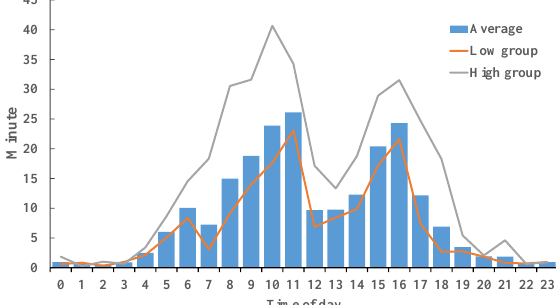
Figure 2. The outdoor time of daily movement per hour. The “High” represents the 20% of the highest total daily outdoor hour, while the “Low” represents 20% of lowest total daily outdoor hour from all subjects’